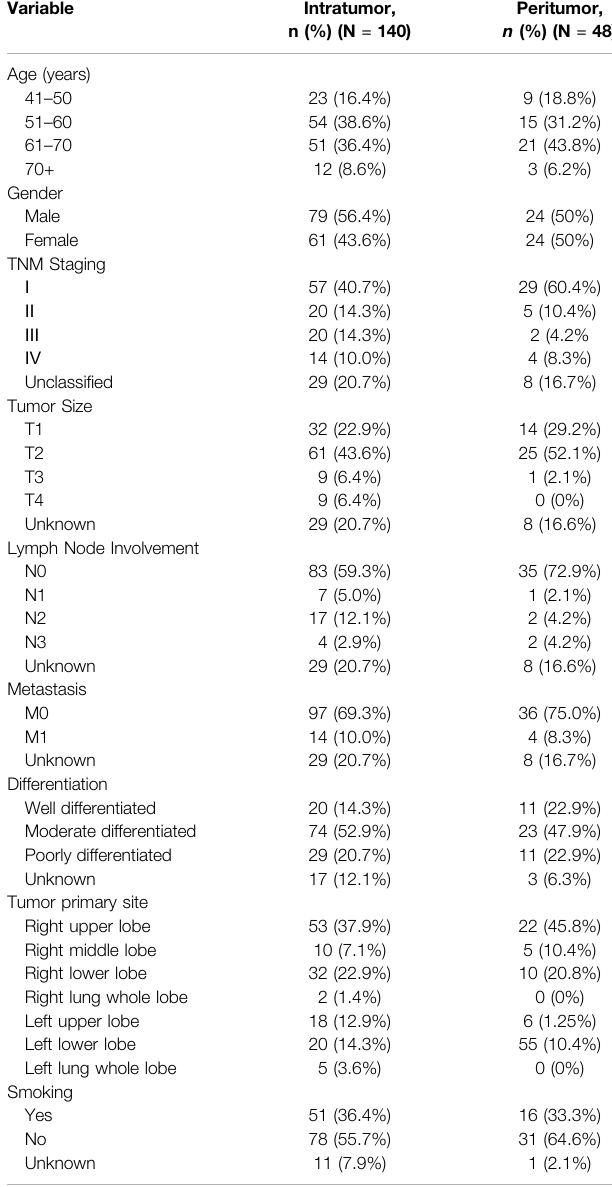
TABLE 1 | Basic pathological information of 140 cases of lung adenocarcinoma.